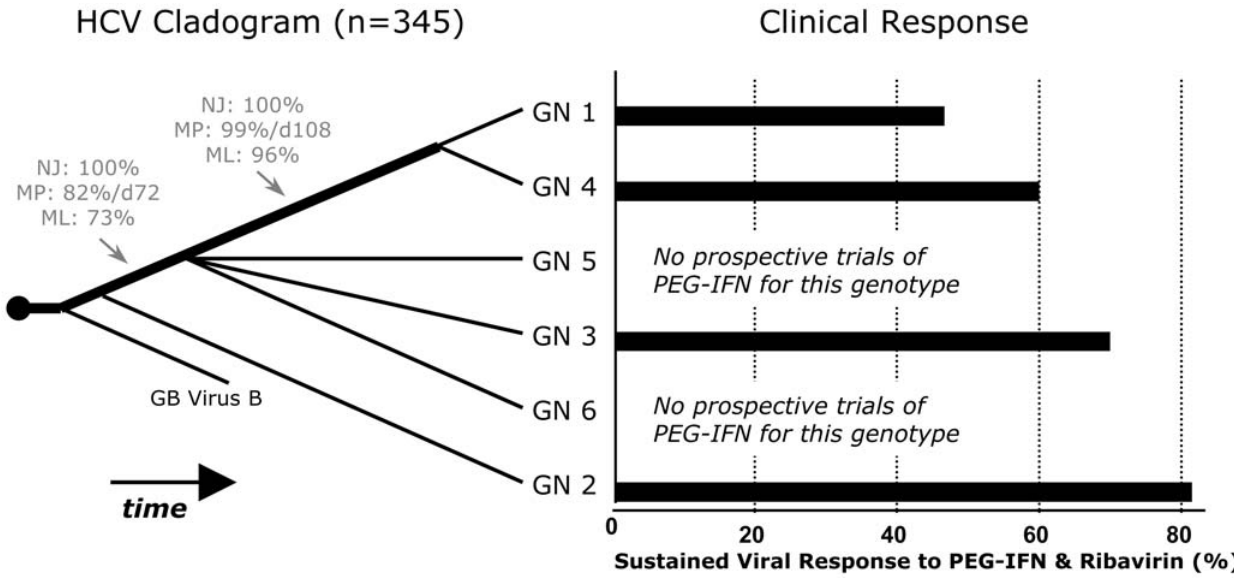
Figure 4. Rooted Consensus Cladogram Resulting From An Analysis of 345 Full-Length HCV Genomic Sequences. The evolution of the major (HCV) genotypes and their correlation to clinical outcome is depicted. Values denote bootstrap support and Bremer decay indices for the indicated phylogenetic inference method.